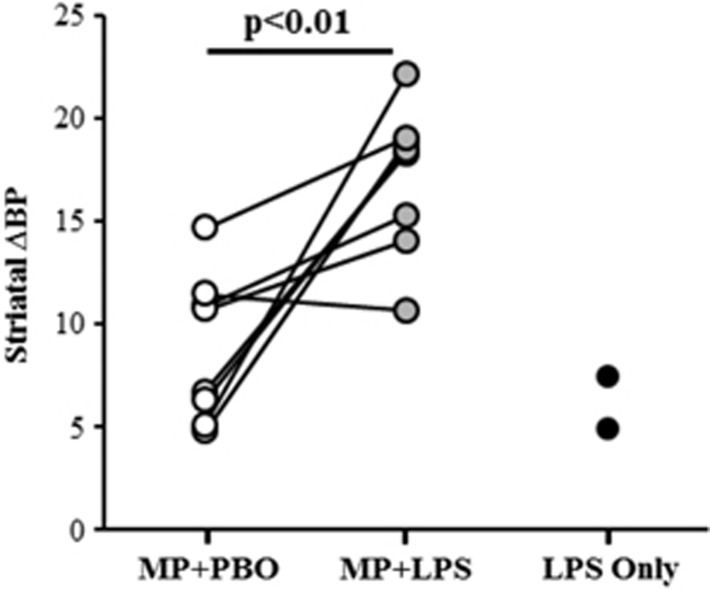
ΔBP values in striatum from each subject in each condition. Seven of eight subjects exhibited greater ΔBP after MP+LPS administration (gray) versus MP+PBO (white; P<0.01). Line segments were added to indicate the same subject in different conditions. Preliminary results (n=2) of ΔBP after LPS alone are plotted in black in the right-most column. These subjects did not receive any other scan condition. BP, binding potential; LPS, lipopolysaccharide; MP, methylphenidate; PBO, placebo.